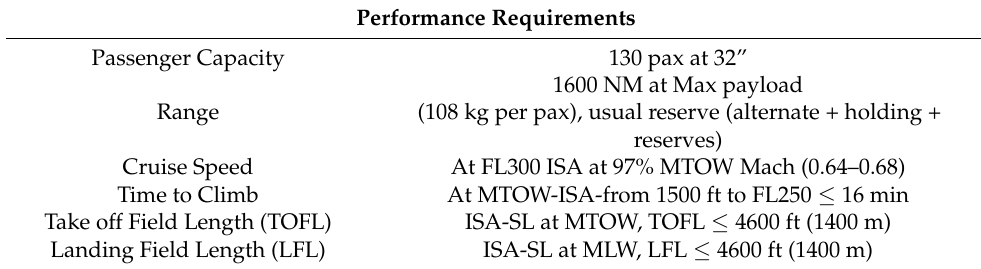
Table 1. Topic Level Aircraft Requirements (TLARs).